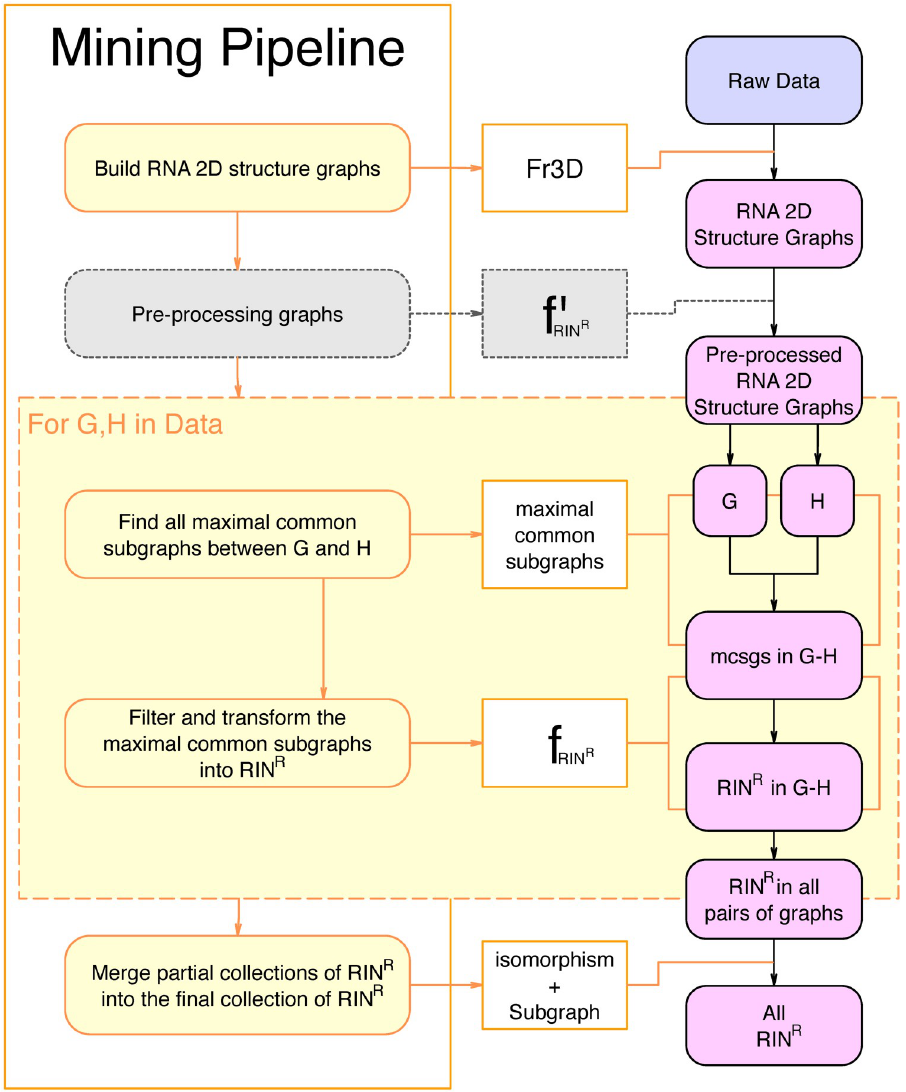
Fig 6. Simplified display of the full pipeline. The RNA 2D structure graphs given as input are pre-processed for the sake of optimization. Each pair of graphs in the pre-processed data is then given to the maximal common subgraphs algorithm as input and the output is post-processed into partial sets of RIN R into the complete set of RIN R which is the output of the whole s